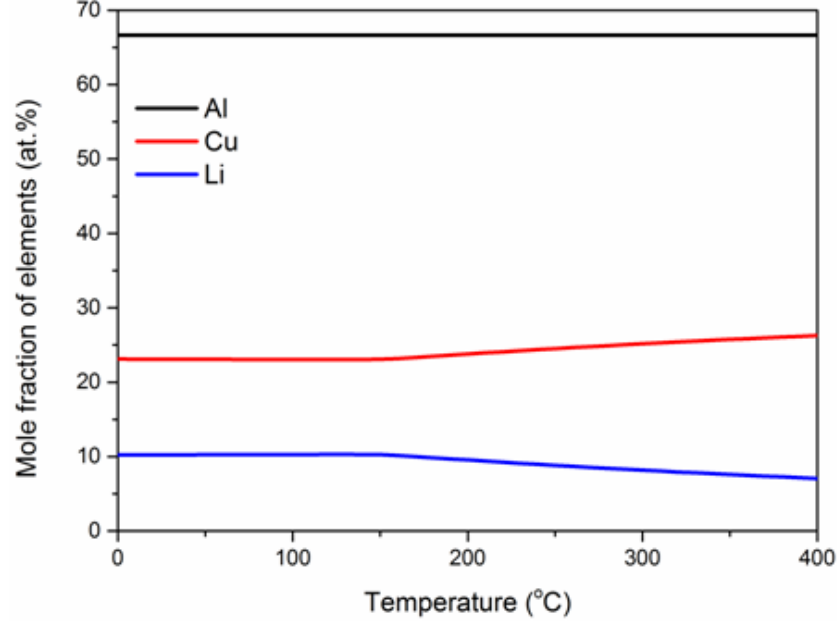
Figure 11. The content of elements in T1-Al2CuLi phase.